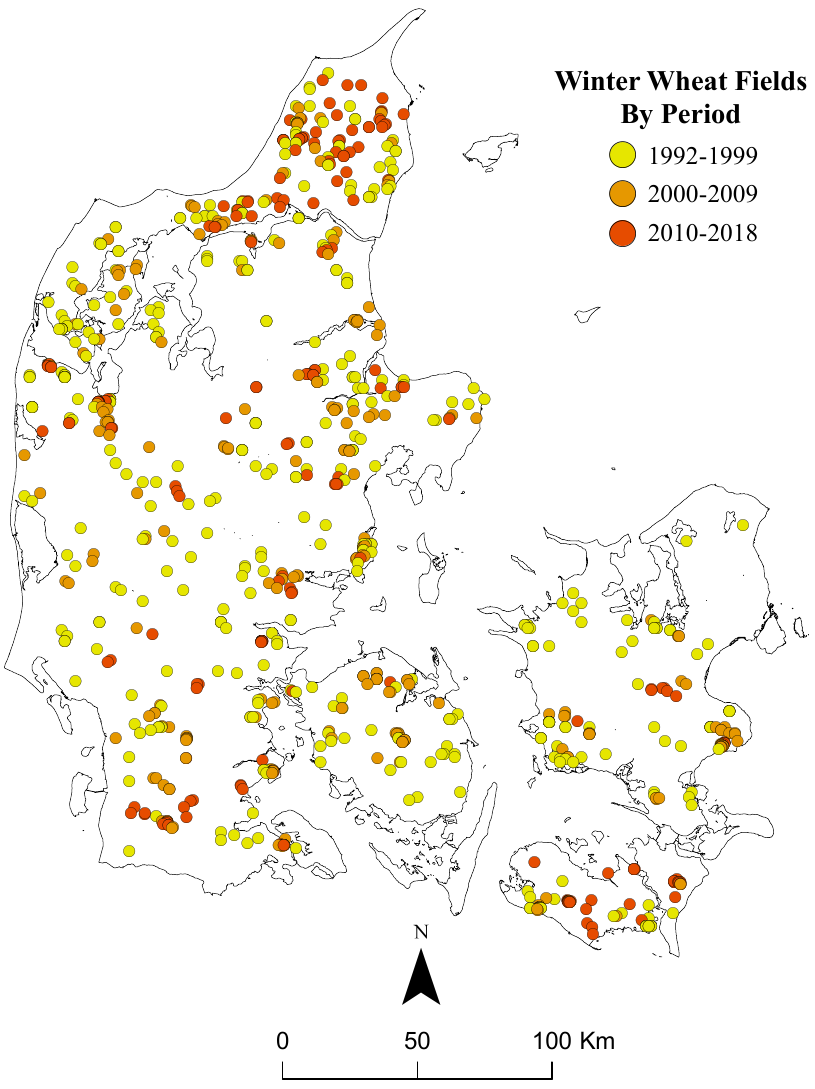
Figure 1. Locations of winter wheat fields (n = 876) from 1992 to